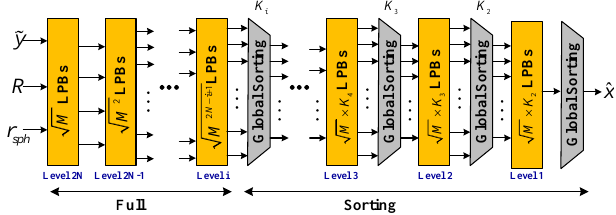
Figure 8. Block diagram of the proposed EHSD for 4 × 4 MIMO.